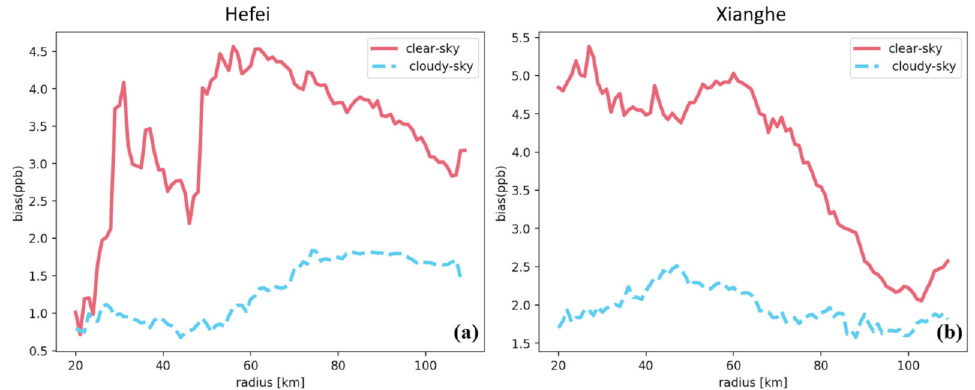
Figure 3. ( a ) The bias of XCO between the TROPOMI data and the FTIR data (TROPOMI–FTIR) as function of the coincident radius around the Hefei site for both clear-sky and cloudy satellite observations. ( b ) The same as ( a ) but for the Xianghe site.